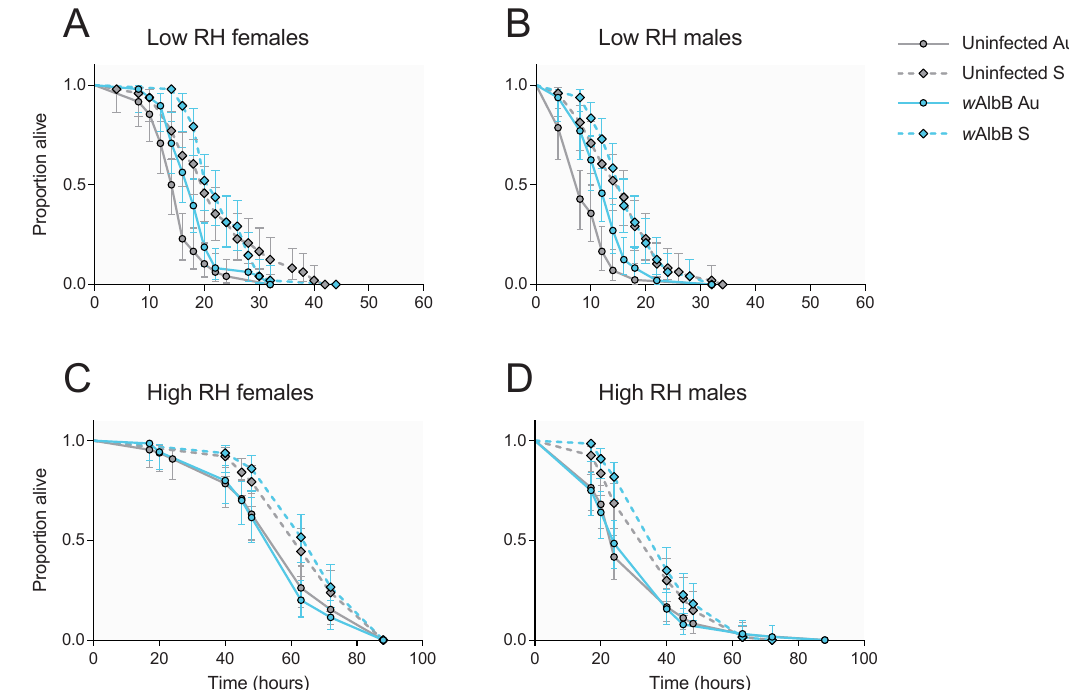
Fig 3. Survival of w AlbB-infected and uninfected Aedes aegypti adults from Australian and Saudi Arabian backgrounds under low (A-B) and high (C-D) relative humidity. Data are presented separately for females (A, C) and males (B, D). Lines show data from 48 (A-B) or 64 (C-D) adults per population. Error bars represent 95% confidence intervals.